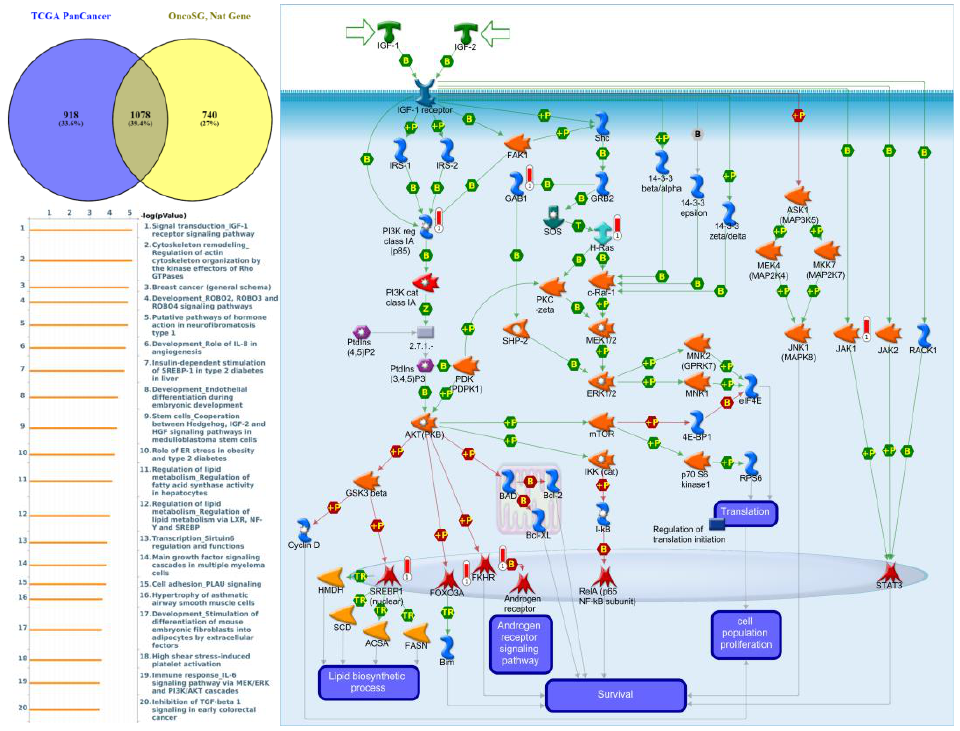
Figure 11. Expression of the protein tyrosine phosphatase non-receptor type 21 (PTPN21) signaling pathway in lung cancer (from Metacore). The functional analysis of “Signal transduction_IGF-1 receptor signaling pathway” was correlated with lung cancer development.